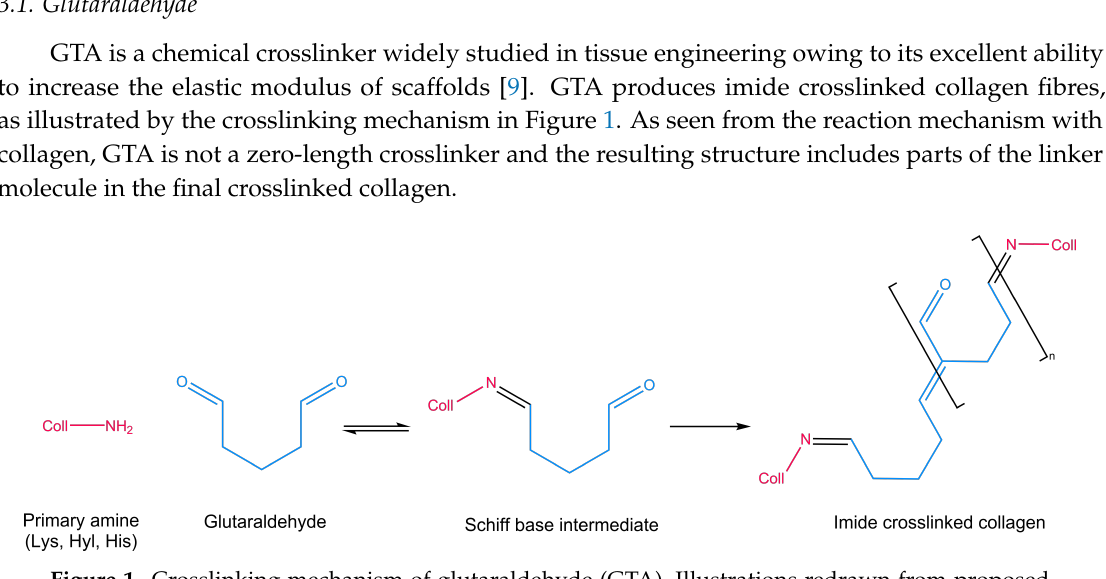
Figure 1. Crosslinking mechanism of glutaraldehyde (GTA). Illustrations redrawn from proposed mechanisms by Olde Damink et al.